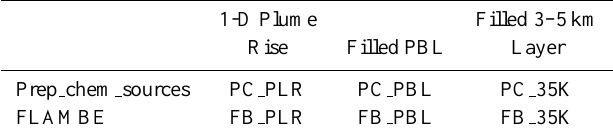
Table 2. Configurations used during our study as defined by the biomass burning preprocessor and injection layer